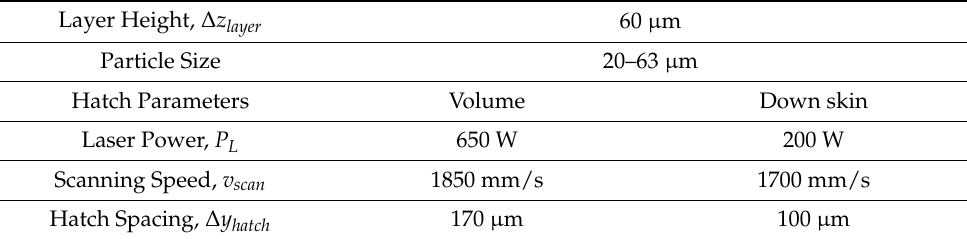
Figure 1. ( a ) LPBF aluminum cooling channel sample; ( b ) end-view of the different investigated channel diameters; ( c ) sketch of the channel sample showing the nominal dimensions and locations for five holes intended for thermocouples. D nom varied between investigated channels. Table 1. Process parameters for LPBF manufacture of the channel samples.